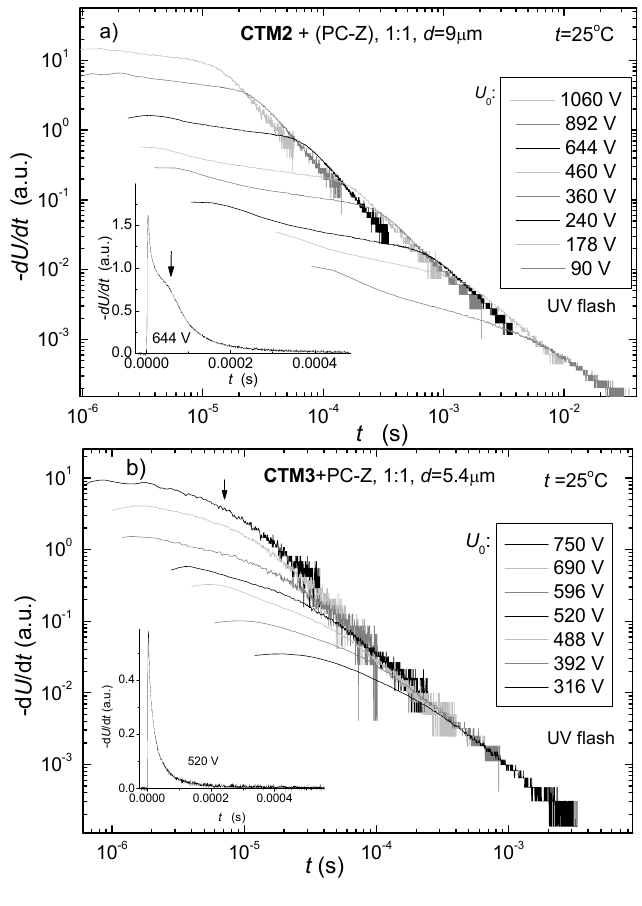
Figure 5. ( a ) XTOF transients for CTM2 (1:1 composition with PC-Z); ( b ) XTOF transients for CTM3 (1:1 composition with